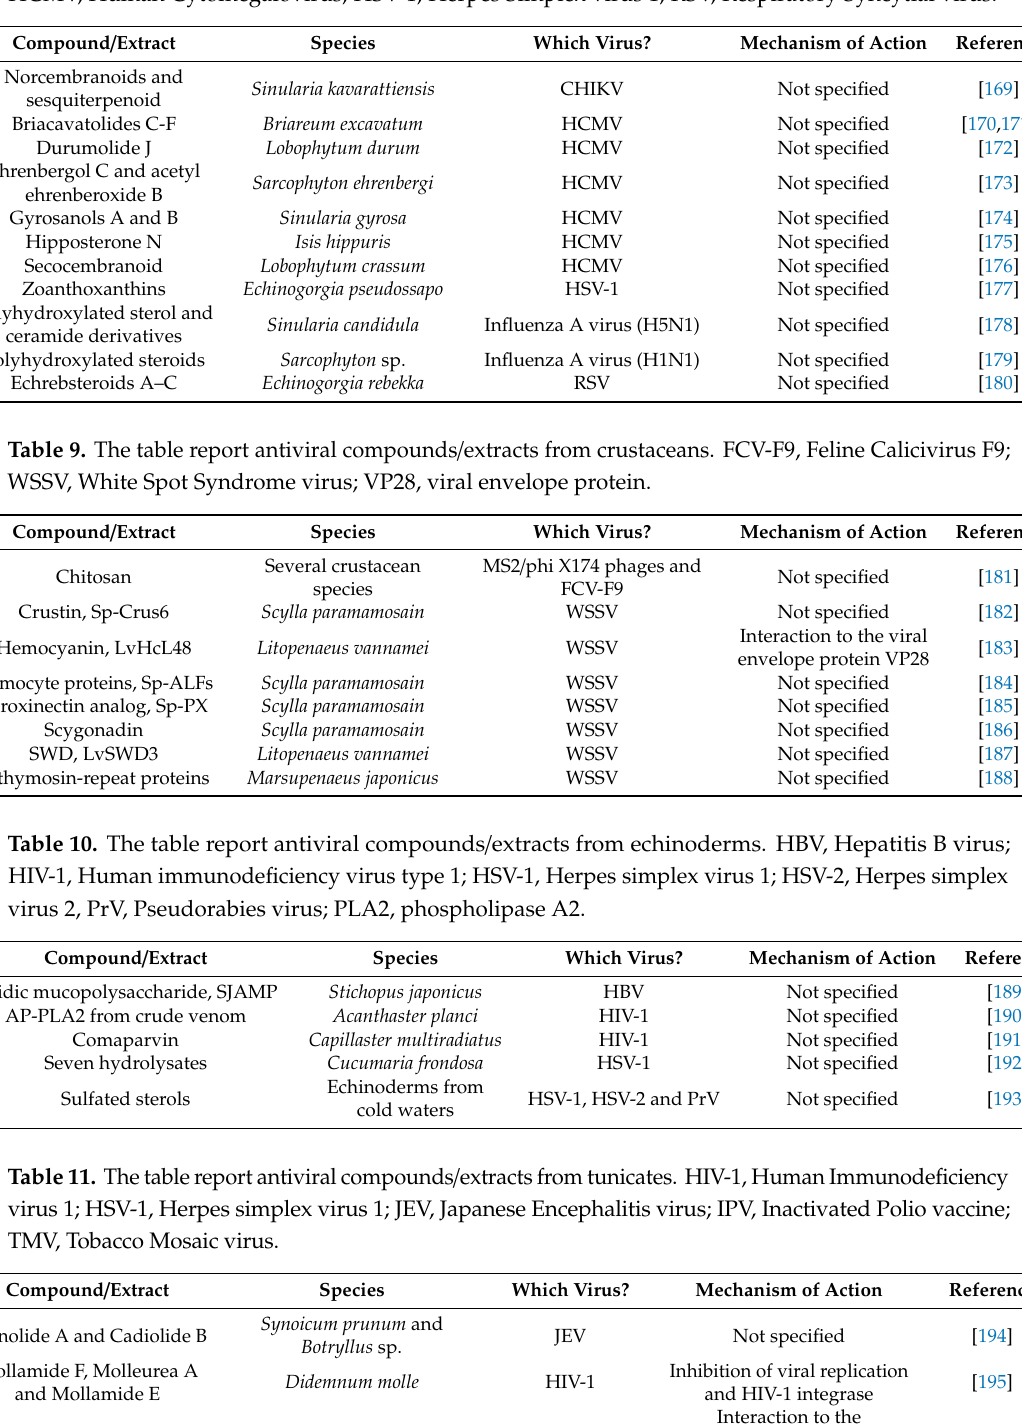
Table 8. The table report antiviral compounds / extracts from cnidarians, CHIKV, Chikungunya virus; HCMV, Human Cytomegalovirus; HSV-1, Herpes Simplex virus 1; RSV, Respiratory Syncytial virus.